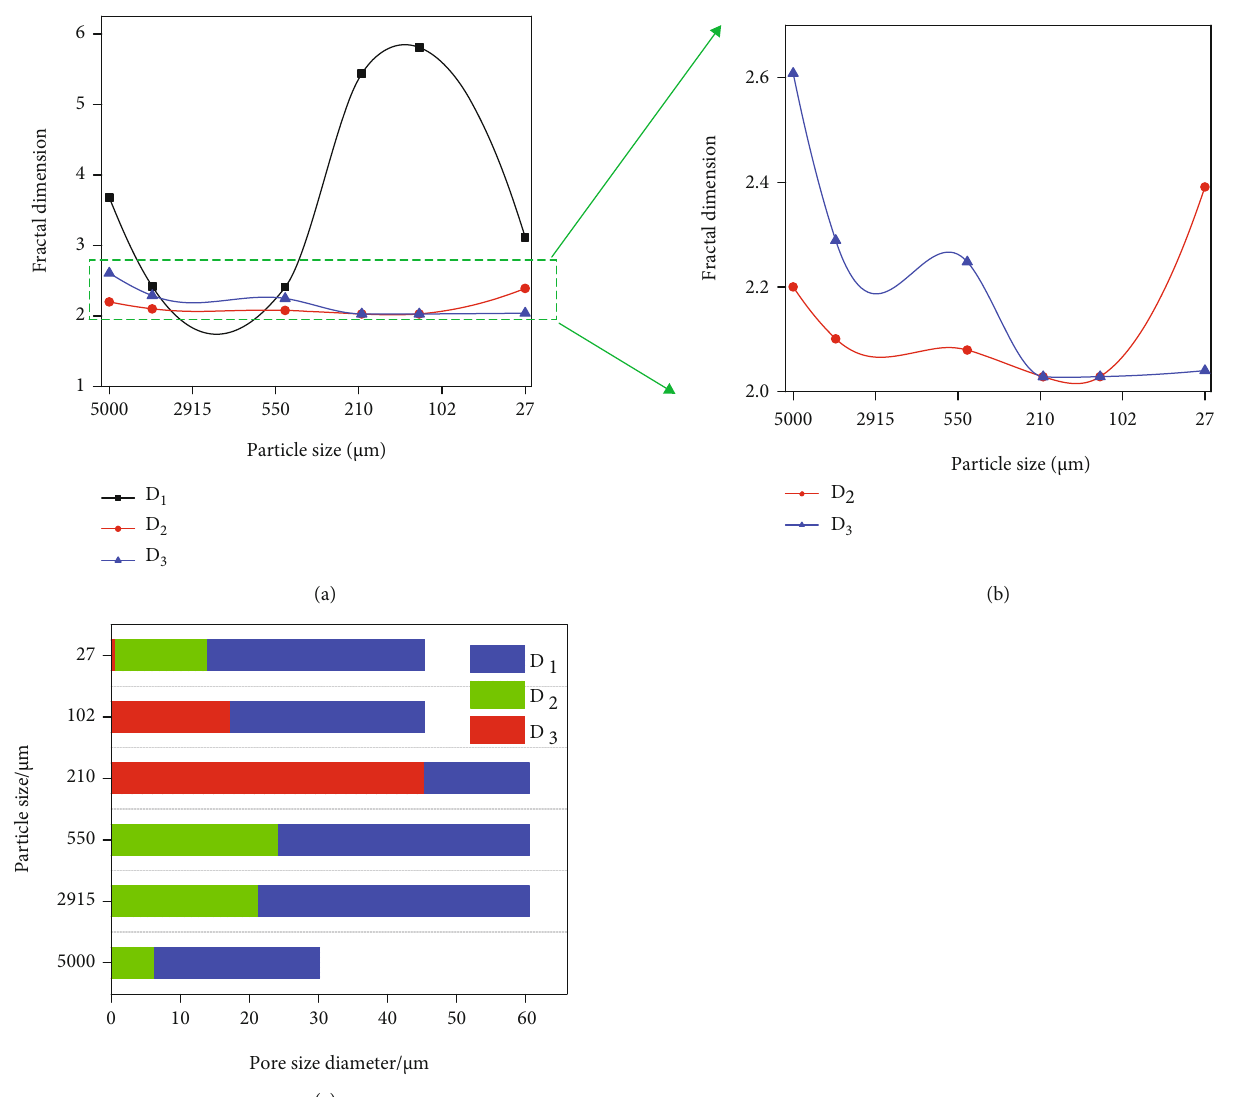
, d , and d of shale samples with 1 2 3 ). (c) The pore size 1